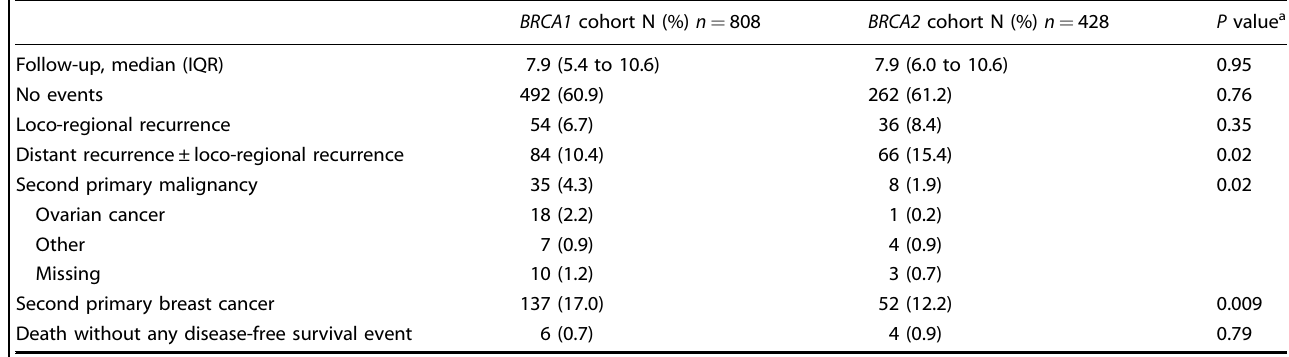
Table 2. Pattern of invasive disease-free survival events according to a type of BRCA-mutated gene.